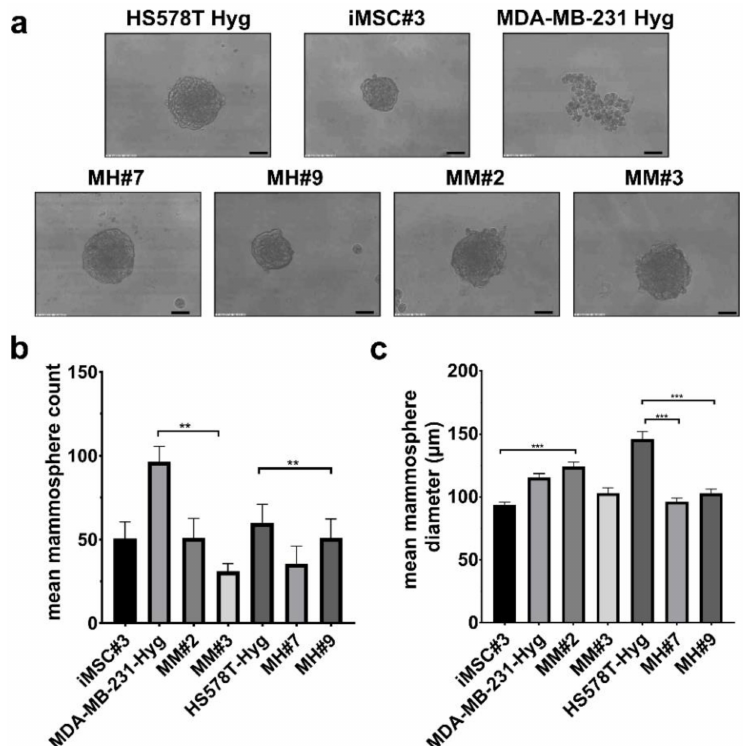
Figure 3. Analyses of di ff erent stem cell characteristics. ( a ) Representative images of mammospheres formed by the appropriate cell lines. Bar = 100 µ m. ( b , c ) Shown are the mean count and diameter values of mammospheres of three independent experiments. Statistical analysis was performed using a one-way ANOVA and post hoc test: ** = p < 0.01, *** = p < 0.001.